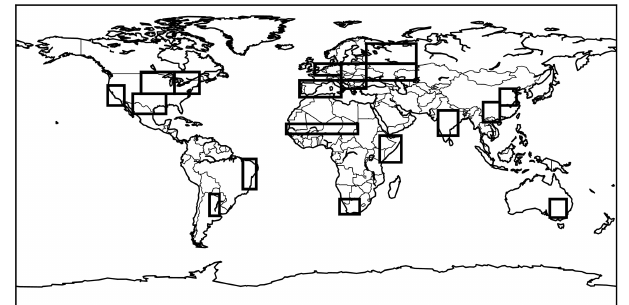
Figure 2. Selection of 19 regions across the globe known for be- ing potential hotspots for droughts and heatwaves. The regions are defined in Table